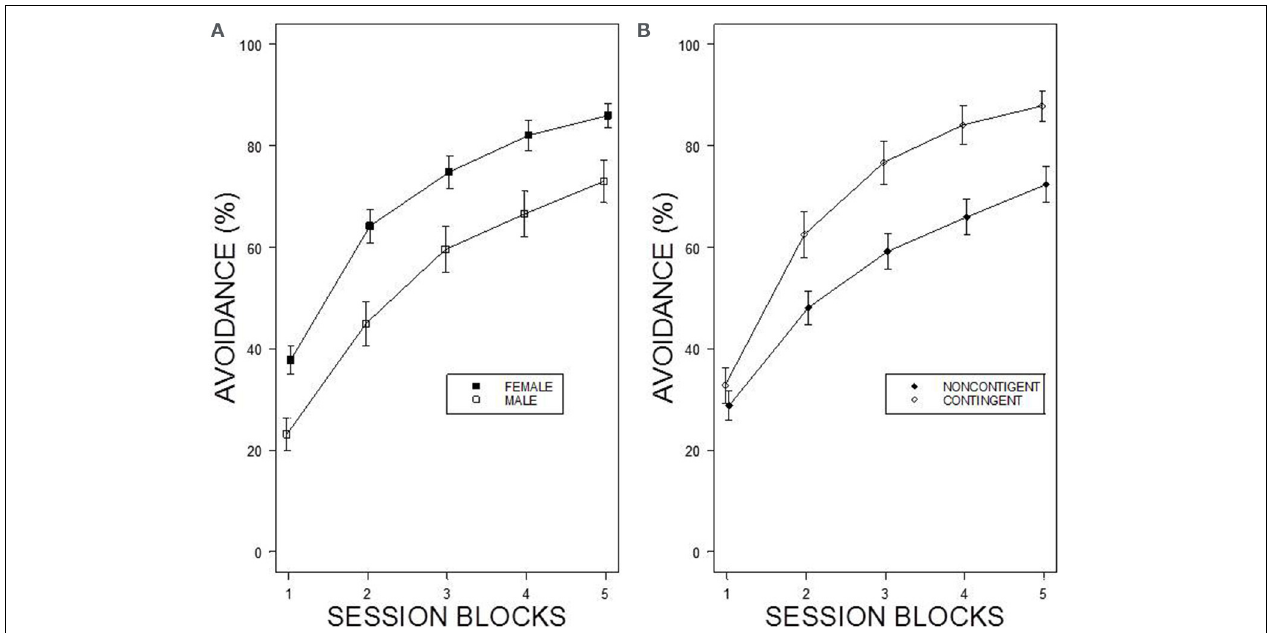
FIGURE 2 | Percentage of avoidance responses across the 5 blocks of the training. (A) The left panel shows sex differences in avoidance acquisition and expression. Female rats exhibit facilitated avoidance acquisition regardless of Strain and Training. Each data point represents group mean ± s.e.m. (Female; n = 47, Male; n = 44). (B) The right panel